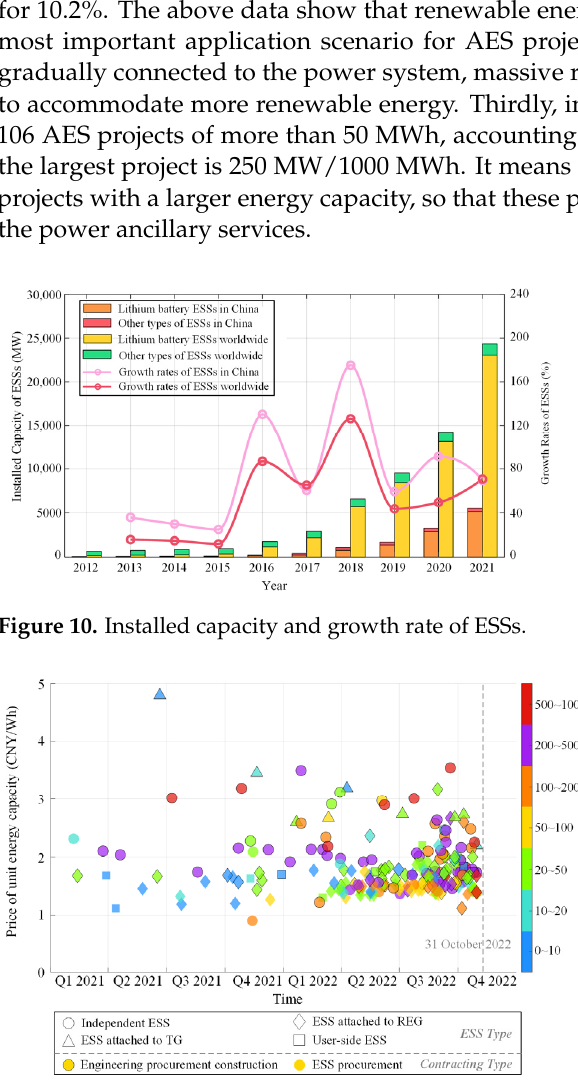
Figure 11. The 215 energy storage projects in China from January 2021 to October 2022.